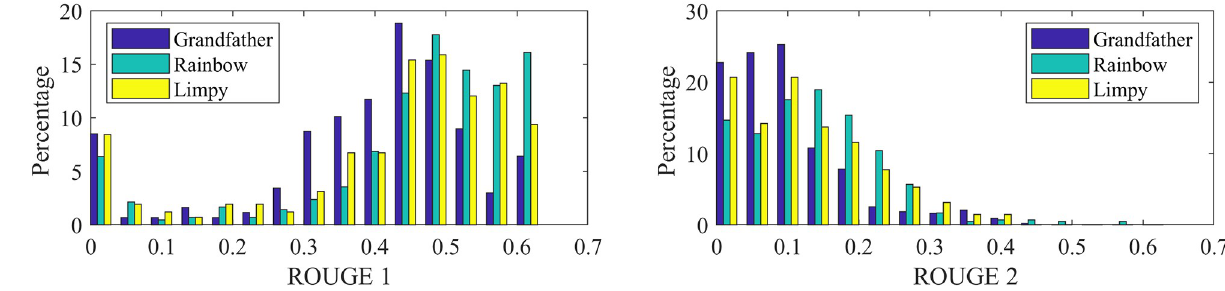
Fig 8. Story recall: Distribution of the average ROUGE-1 (ROUGE-2) scores for different stories on right (left).